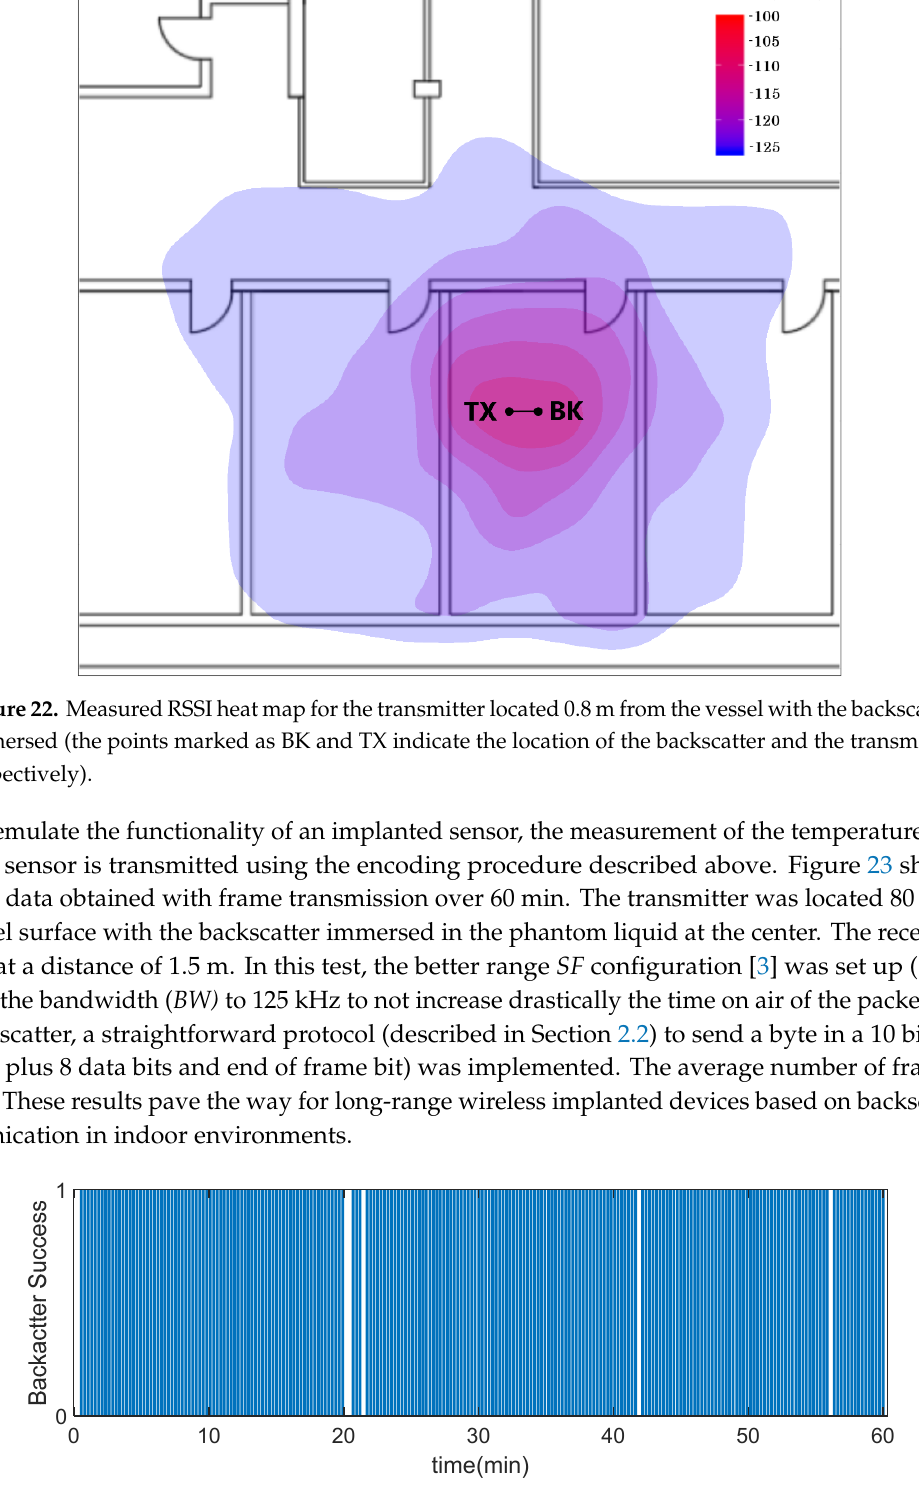
Figure 23. Backscattered frames successfully received as a function of the time with the backscatter immersed in the center of the vessel with a phantom liquid for a transmitter located 0.8 m from the vessel.